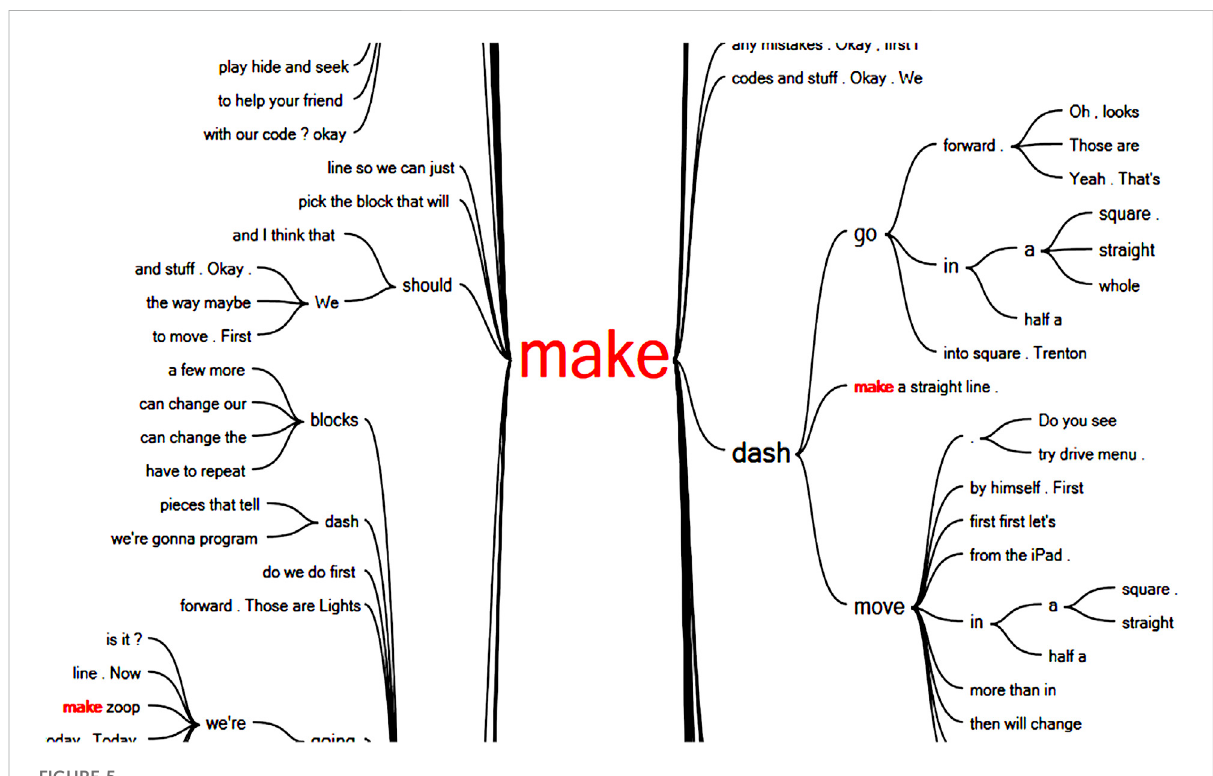
FIGURE 5 Text query word tree for “ make ”